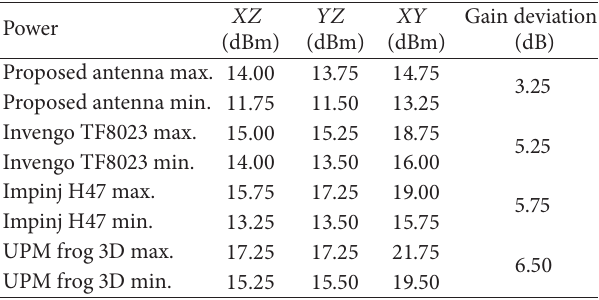
Figure 10: Measurement environment of the tag. Table 5: Minimum power required for the test of the four kinds of tag antennas in three